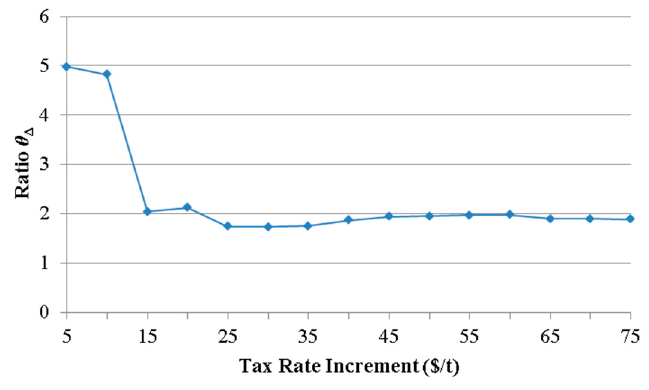
Figure 4. Variation of θ Δ with the increase of tax-rate increment.